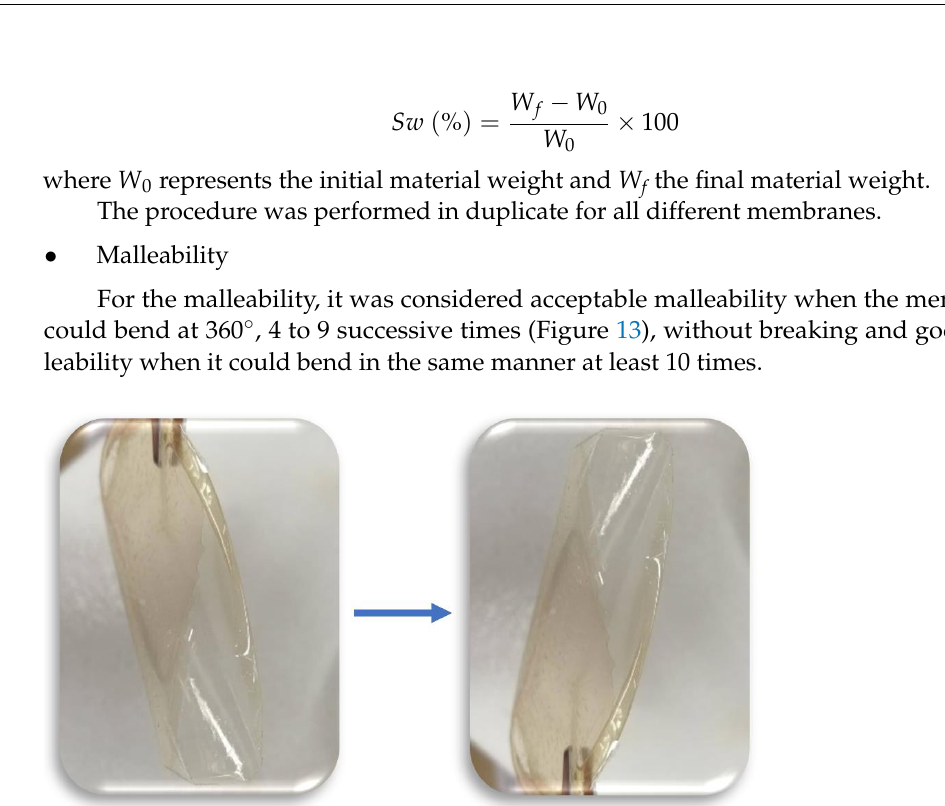
Figure 13. Representation of membrane bending used for determination of its malleability.